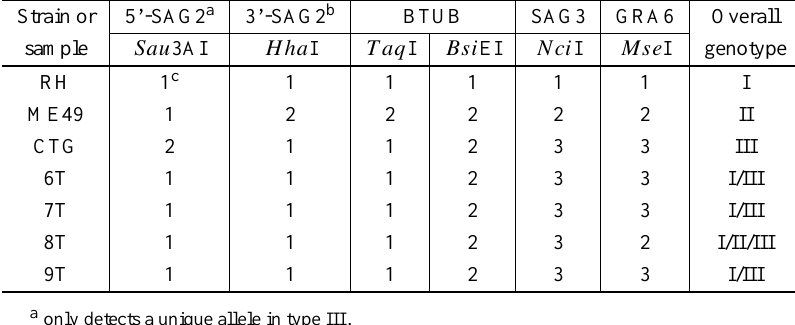
Genotypes of T. gondii samples detected in porcine samples from Erichim, Brazil. Strain or 5’-SAG2 a 3’-SAG2 b BTUB